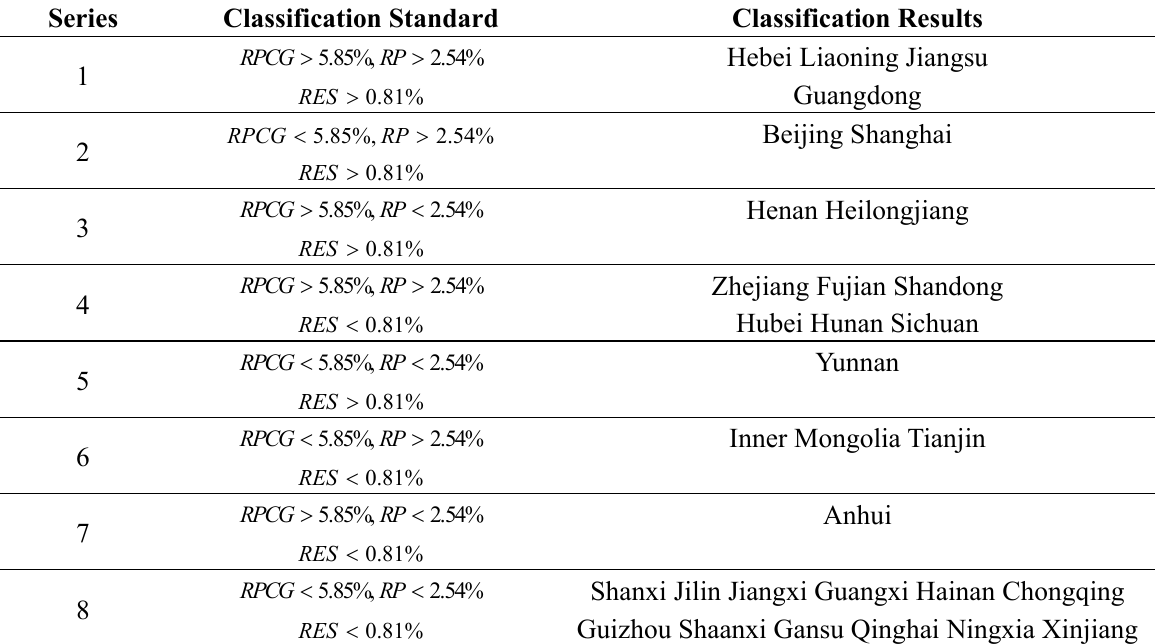
Table 4. Different areas of China’s classification criteria and classification